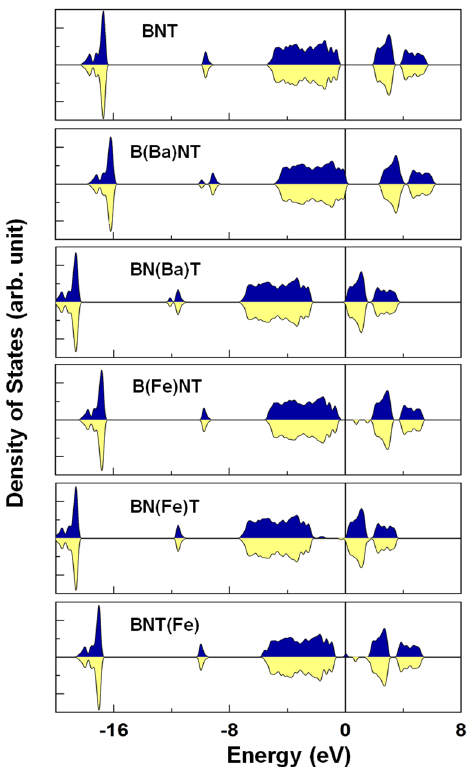
Figure 10. Top to bottom: The DFT results of the spin-resolved DOS for the BNT, B(Ba)NT, BN(Ba)T, BNT(Fe), B(Fe)NT, and BN(Fe)T. The Fermi level is set to zero